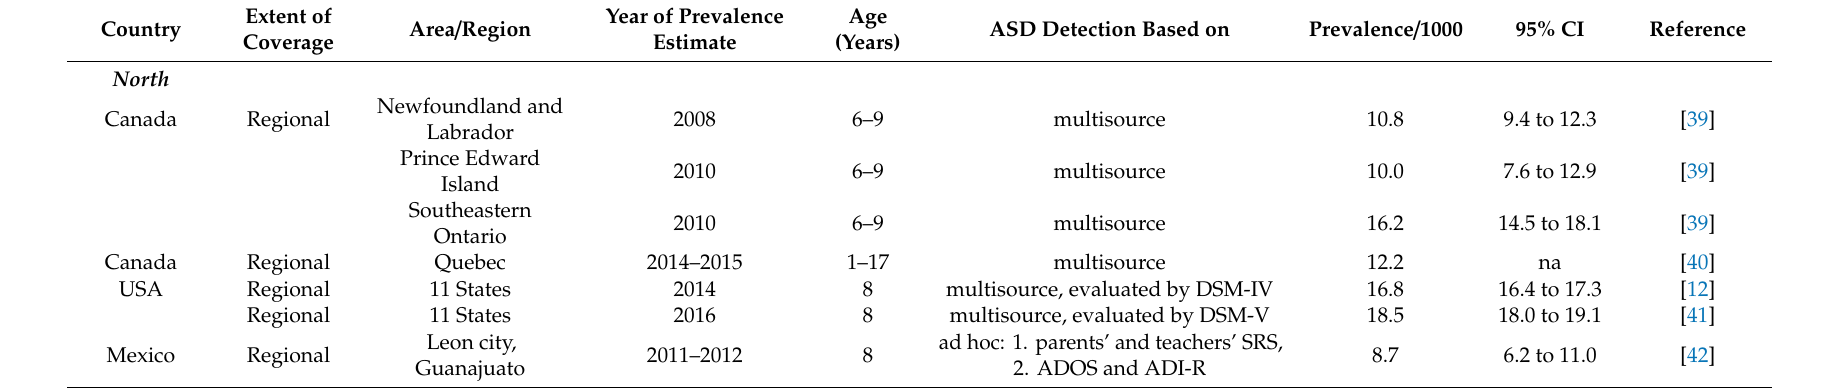
Table 4. Summary of prevalence studies published since 2014 in North